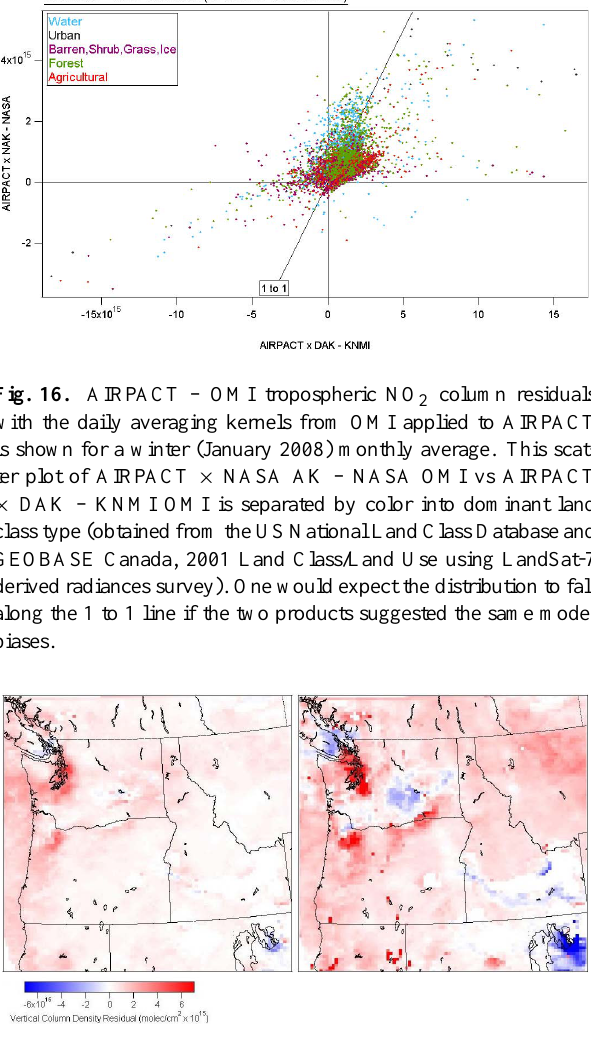
Fig. 17. AIRPACT – OMI tropospheric NO 2 column residuals with the daily averaging kernels from OMI applied to AIRPACT is shown for a winter (January 2008) monthly average. AIRPACT × NASA AK - NASA OMI is shown on left while AIRPACT × DAK – KNMI OMI is shown on the right. Some values are over 6 × 10 15 molecules per square centimeter as shown in Fig. 16. Note the large positive bias found in discrete pixels in the right panel, in- dicative of extreme negatives in the KNMI data product dominating the monthly average of an unpolluted area, apparently due to the stratospheric subtraction methods